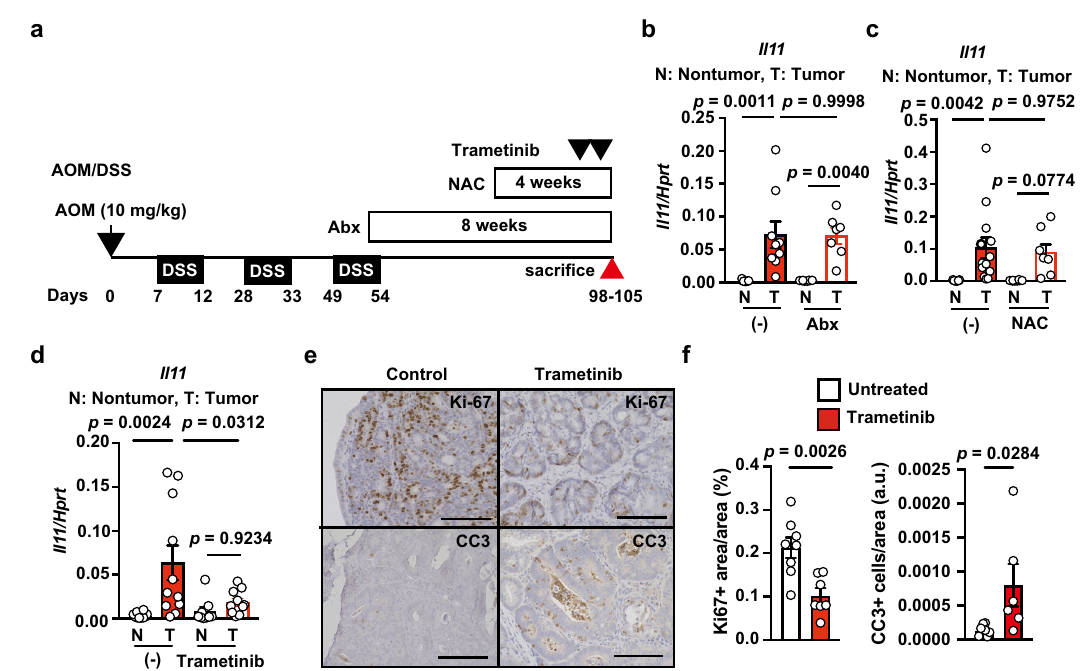
Fig. 6 Blockade of the MEK/ERK Pathway reduces proliferation and induces apoptosis in Tumor Tissues of AOM/DSS-treated mice. a Schema of administration of various inhibitors in AOM/DSS-treated mice. b – f After induction of colorectal tumors, wild-type mice were not treated or treated with Abx for 8 weeks ( b ), NAC for 4 weeks ( c ), or trametinib at − 6 and − 30 h ( d – f ) (before sacri fi ce). On day 98 – 105 after AOM injection, mRNA was extracted from tumor (T) and non-tumor tissues (N), and Il11 expression was determined by qPCR ( b – d ). Results are mean ± SEM. n = 9 (untreated), 8 (nontumor, Abx-treated), or 7 (nontumor, Abx-treated) mice; pooled data from two independent experiments ( b ). n = 13 (untreated) or 8 (NAC-treated) mice; pooled data from two independent experiments ( c ). n = 10 (nontumor, untreated), 11 (tumor, untreated), 9 (nontumor, trametinib-treated), or 10 (nontumor, trametinib-treated) mice; pooled data from four independent experiments ( d ). Colon tumor sections were stained with anti-Ki67 or anti-CC3 antibodies ( e ). Ki67 + area and total area were calculated and the percentages of Ki67 + area per area are expressed ( f ). n = 8 (untreated) or 7 (trametinib- treated) mice. Numbers of CC3 + cells were counted and the total area was calculated, and CC3 + cells per area are expressed as arbitrary units (a.u.) ( f ). n = 8 (untreated) or 6 (trametinib-treated) mice. Statistical signi fi cance was determined using the unpaired two-tailed Student ’ s t -test ( f ) and two-way ANOVA with Tukey ’ s multiple comparison test ( b – d ). Source data are provided as a Source Data fi